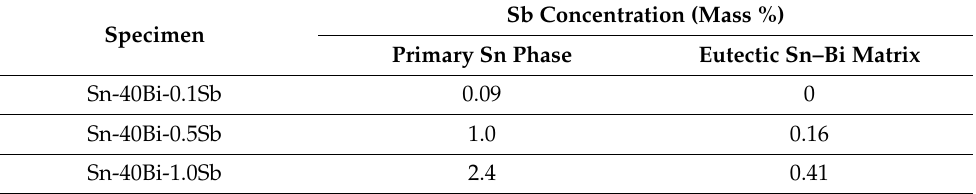
Table 1. EPMA results of the Sn-40Bi-Sb alloys.